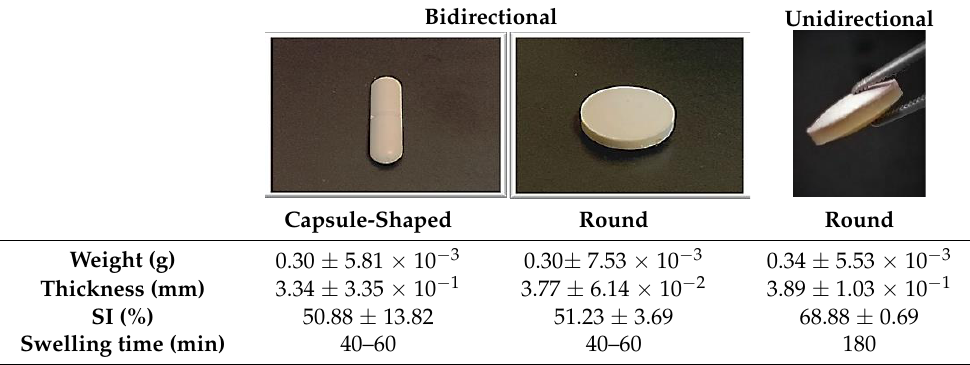
Figure 8. Mean swelling profile obtained for capsule-shaped and round bidirectional tablets. n = 3. The geometry ’ s influence on the tablet ’ s accommodation and permanence in the sub- lingual cavity was evaluated in healthy volunteers who reported that round tablets were more comfortable, easier to adhere to the buccal epithelium and retained longer in the sublingual cavity (results summarized in Table S2). Taken together, the data point to the round tablets being superior to the capsule-shaped ones. Therefore, the round tablets were selected to perform the rest of the liposome release and permeation studies. Since the mu- coadhesive vehicle proposed here is aimed at systemic delivery, and unidirectional tablets are beneficial for this objective, unidirectional tablets were prepared from bidirectional ones by adding an alginate layer on one of the tablet sides. Direct compression of alginate powder produced better results than compression of the same amount as a lyophilized cake, the latter leading to tablets showing a tendency to film detachment. As reported for bidirectional tables, unidirectional ones showed high uniformity for weight and thickness with mean values of 0.34 ± 5.53 × 10 −3 g and 3.89 ± 1.03 × 10 −1 mm, respectively. These values (in Table 2) are slightly higher than observed for bidirectional tables, showing increases of 13.33% and 3.18% for weight and thickness, respectively. With respect to swelling, SI = 221.43 ± 7.11 was found. Significant differences between unidirectional and bidirectional tables were found for SI ( p = 0.0037), but not for swelling